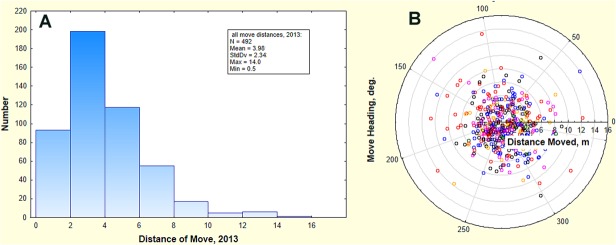
Distance and direction of moves.A. Frequency distribution of the distance moved by colonies in the Ant Heaven population. B. Colonies moved in random directions for an average of 4 m, assuring that over multiple moves, colonies performed random walks around their initial locations. Each symbol color represents a different survey during 2013.